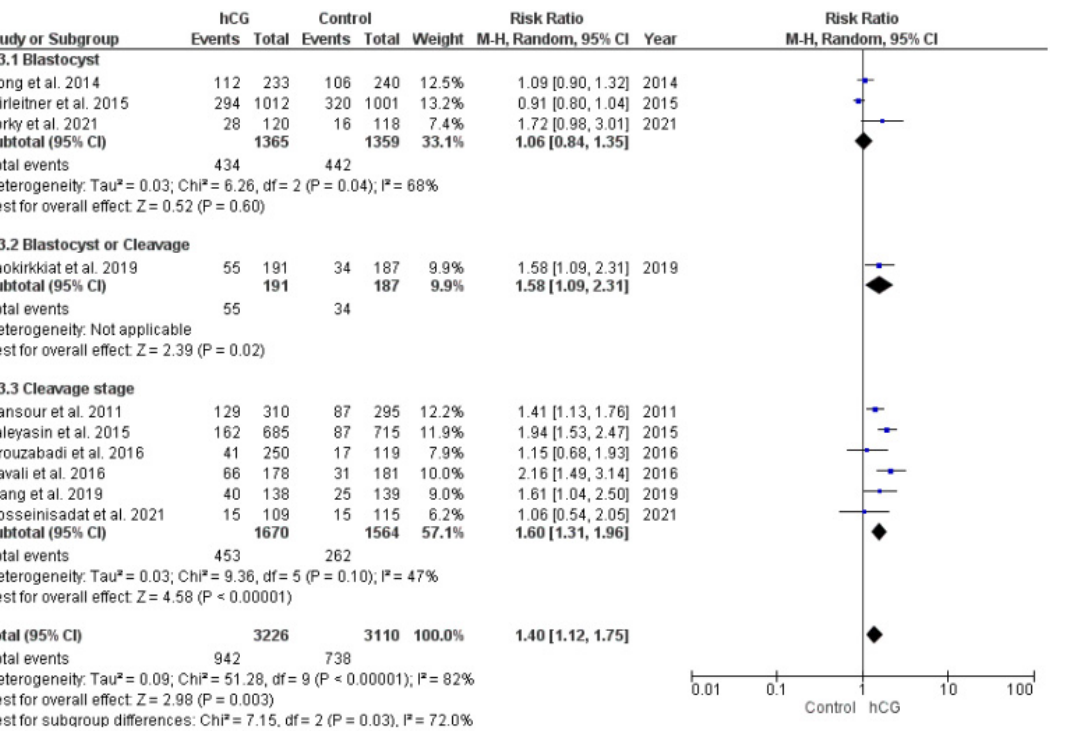
Figure 4. Forest plot showing the effect of intrauterine hCG injection versus control group on implantation rate.